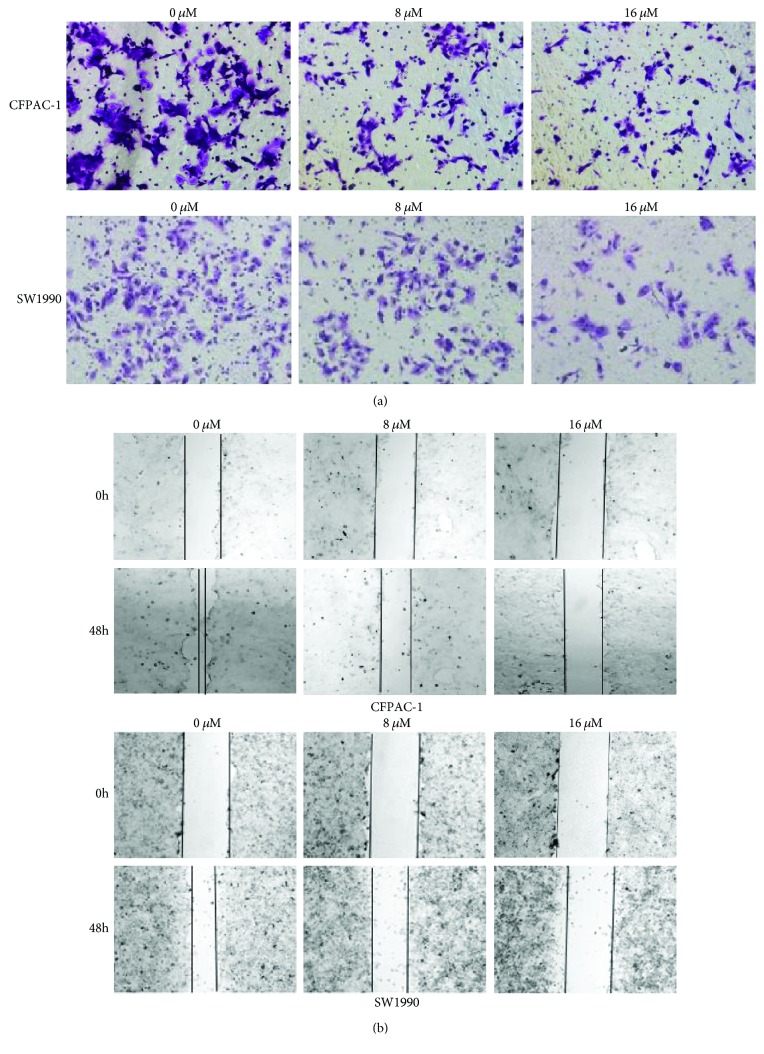
Apatinib inhibited the migration of pancreatic cancer cells. (a) The migration of CFPAC-1 and SW1990 cells after treatment with apatinib (0, 8, and 16 μM) for 30 h was assessed using the transwell assay. The migrated cells on the bottom surface of the filters were stained. (b) The movement ability of CFPAC-1 and SW1990 cells after treatment with apatinib (0, 8, and 16 μM) for 48 h was detected using scratch wound healing assays. All experiments were performed in triplicate.